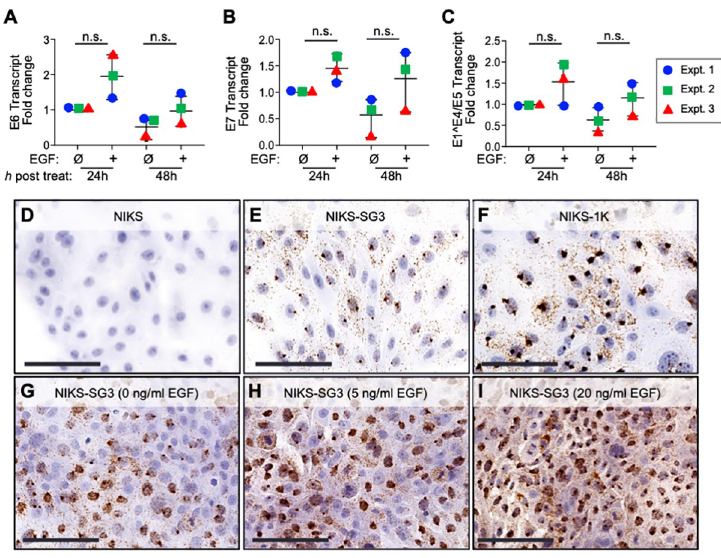
analyzed using 1-way ANOVA with Dunnett’s T3 multiple comparison test post hoc (not significant [n.s.]). (D-F) RNA ISH specific for hr-HPV E6/E7 RNAs on cells cultured with 10ng/ml EGF; (G-I) dose-effect of EGF on cells grown for 24h with or without added EGF (G-I). Bars equal 100 μ